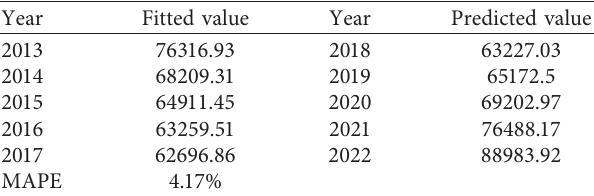
Table 4: Revenue scale (hundred million